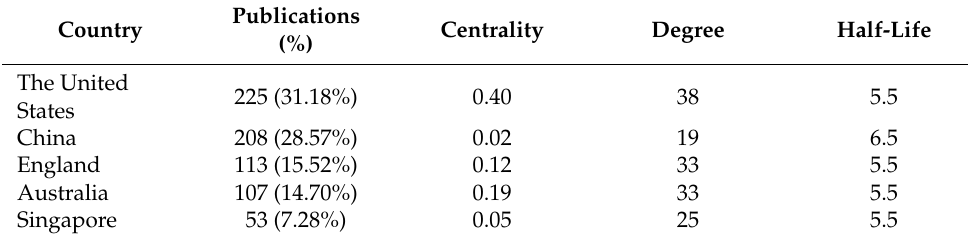
Figure 2. Number of publications per country and year. Table 1. The five countries with the highest number of publications.